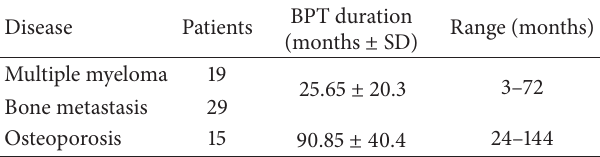
Table 4: Patients with stage I BRONJ evaluated in the present study. Disease Patients